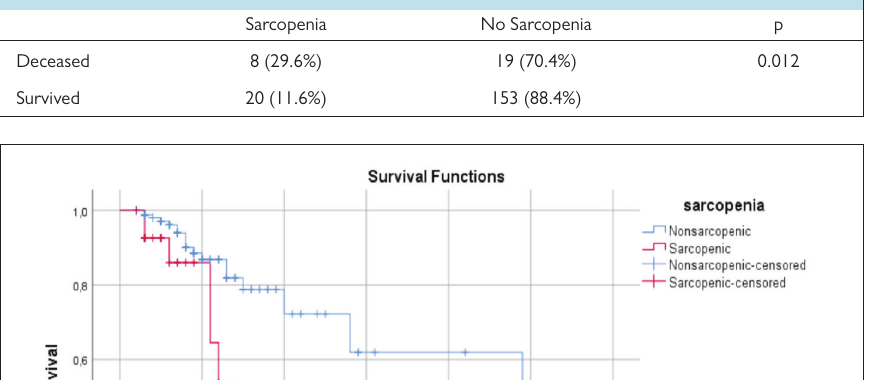
Table 4. Association between sarcopenia and mortality Sarcopenia